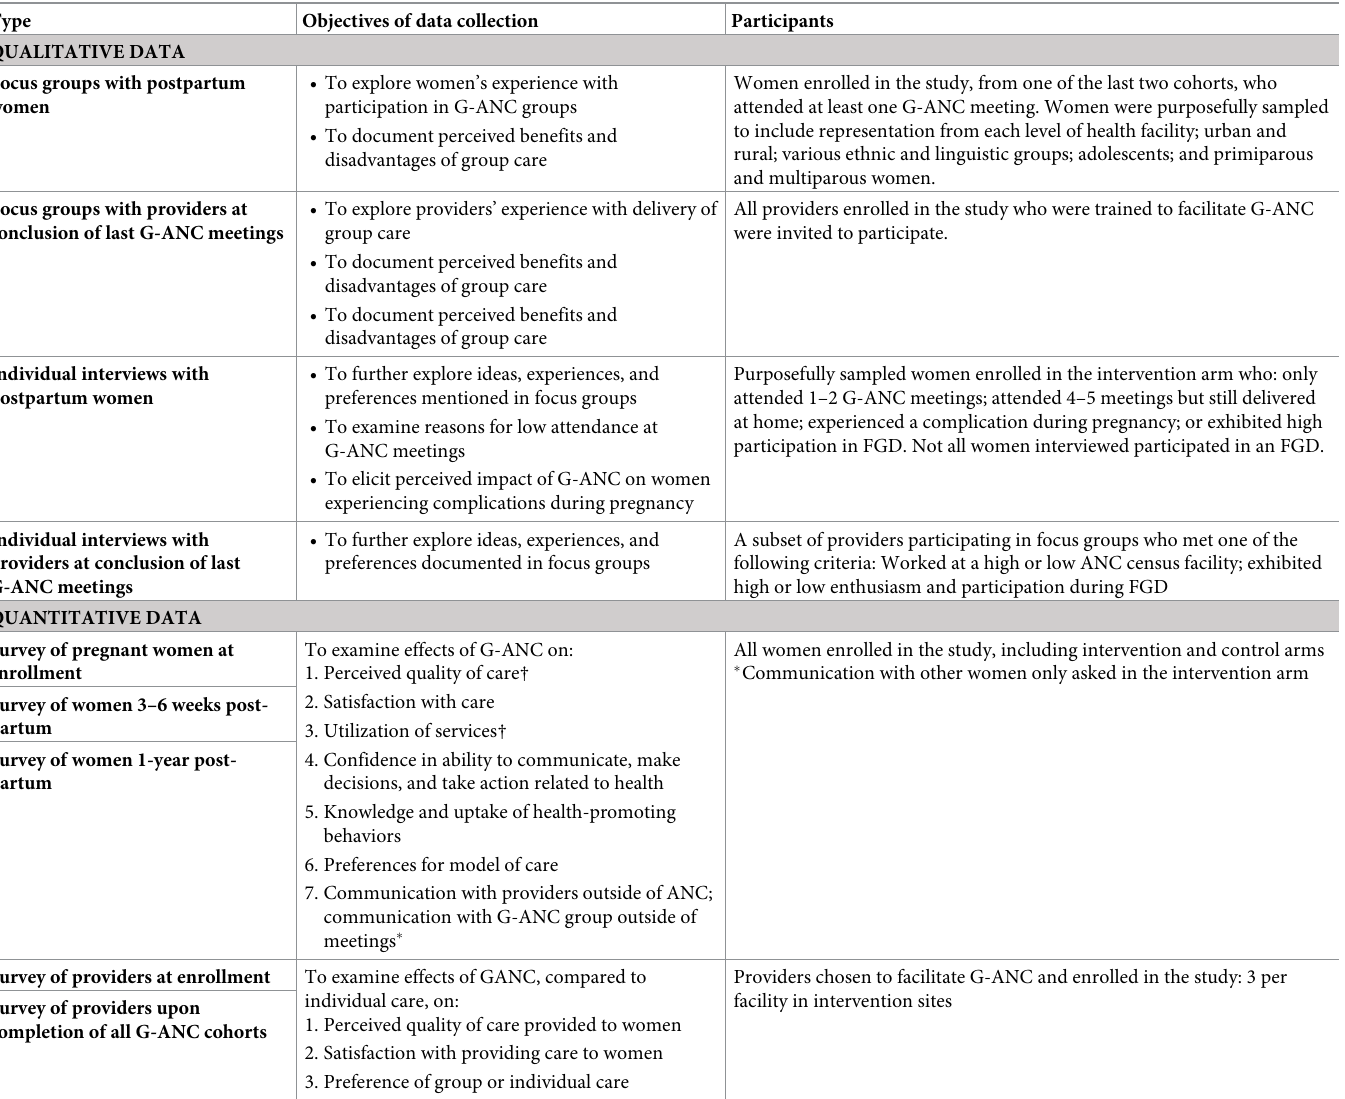
Table 1. Overview of data sources and corresponding